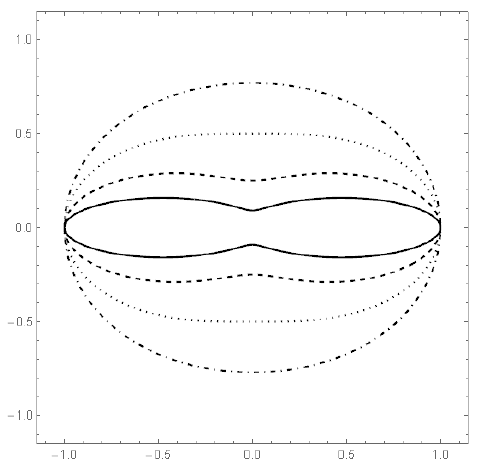
Figure 1. Plot of the boundaries of K in the cases a = 10 (solid line), a = 3 (dashed line), a = 1 (dotted line) and a = 0.3 (dashed/dotted line).